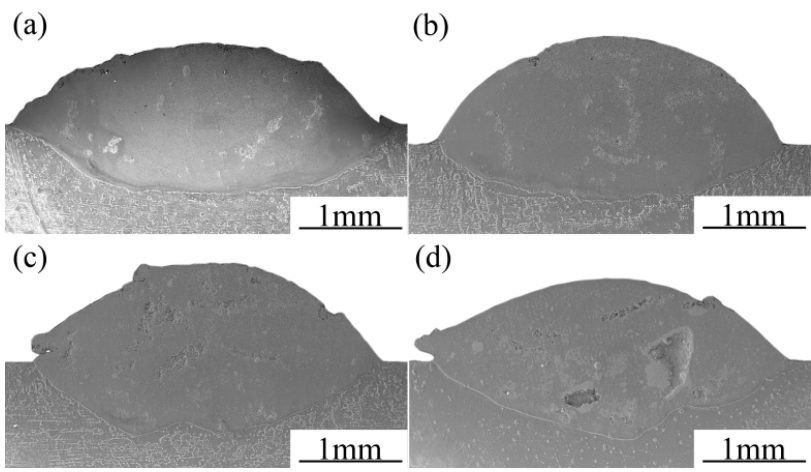
Figure 2. Cross-section of the composite coatings: ( a ) Al+5wt.%TiC; ( b ) Al+10wt.%TiC; ( c ) Al+15wt.%TiC; ( d ) Al+20wt.%TiC.